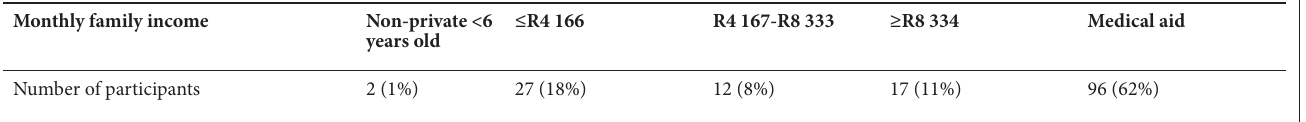
Table 1. Monthly family income classification of